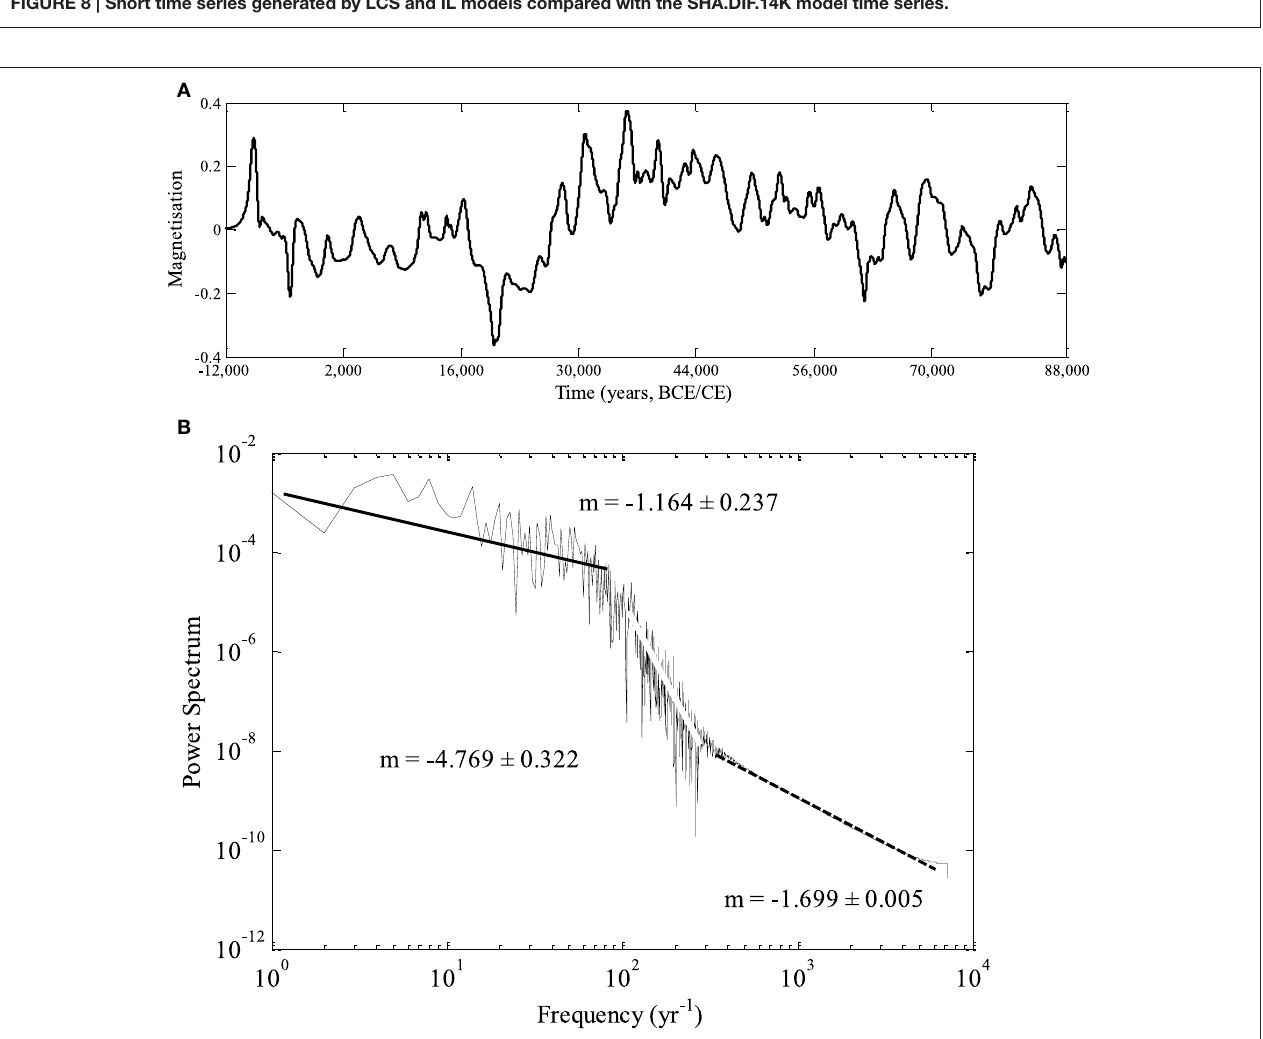
FIGURE 9 | (A) The time series generated by the IL model which comprises 100,000 years, from time series.